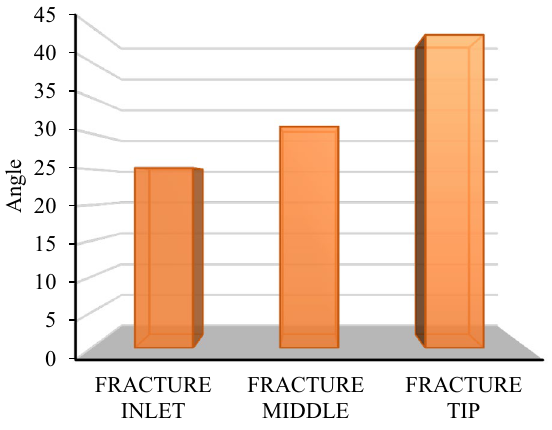
Fig. 8 Gel propagation angles (gel particle size to fracture width ratio is 0.47)